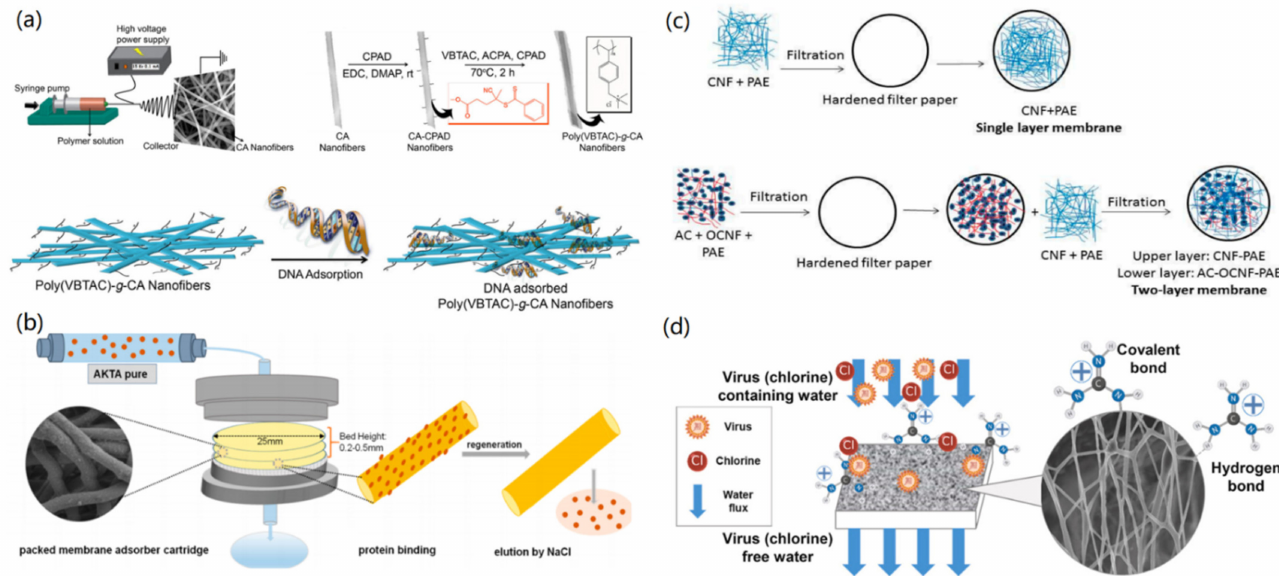
Figure 9. CNF-based functional nanomaterials for the removal of bio-contents: ( a ) Removal of DNA. Reproduced with permission from Ref. [107], Copyright 2014, Elsevier Ltd. ( b ) Removal of protein. Reprinted with permission from Ref. [108], Copyright 2018, American Chemical Society. ( c ) Removal of bacteria. Reprinted with permission from Ref. [109], Copyright 2017, MDPI. ( d ) Removal of virus. Reprinted with permission from Ref. [110], Copyright 2020, Elsevier